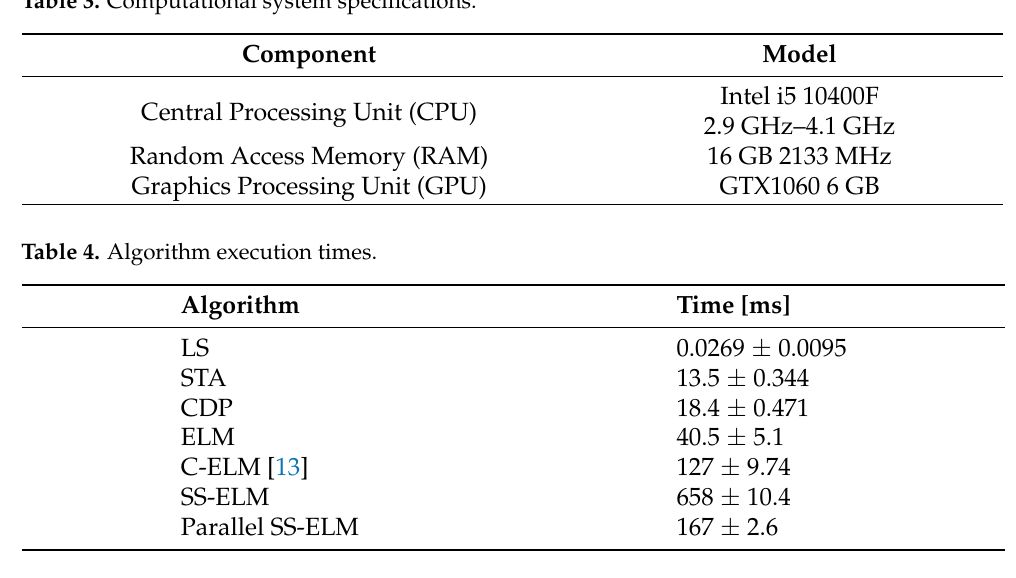
Table 3. Computational system specifications.